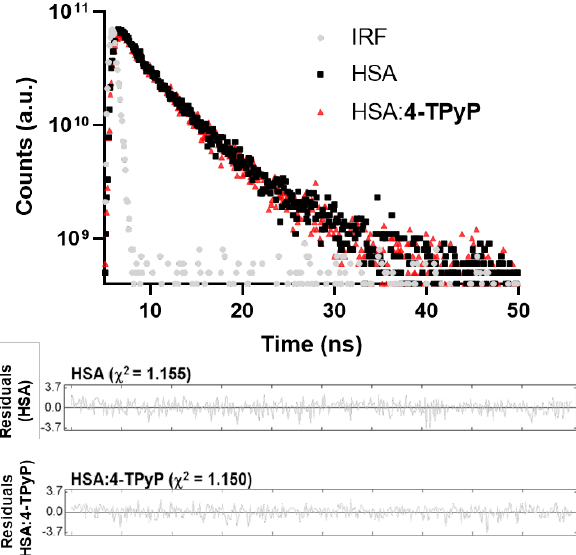
Figure 3. Time-resolved fluorescence decays for HSA without and with 4-TPyP at pH = 7.4 and 296 K using an electrically pumped laser (EPL) with an excitation wavelength of 280 ± 10 nm, pulse width of 850 ps, and a typical average power of 1.8 µW/pulse, monitoring emission at 340 nm. The residuals correspond to the bi-exponential treatment. [HSA] = 1.0 × 10 −5 M and [4-TPyP] = 1.32 × 10 −5 M.